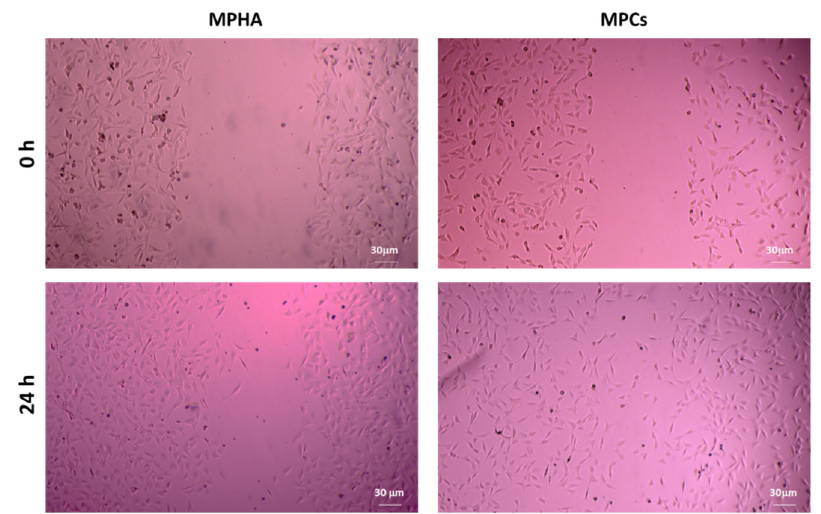
Figure 10. Representative micrographs (4x magnification) of BALB/3T3 clone A31 murine embryonic fibroblast cell monolayers treated with MPHA ( left ) or with MPCs ( right ).